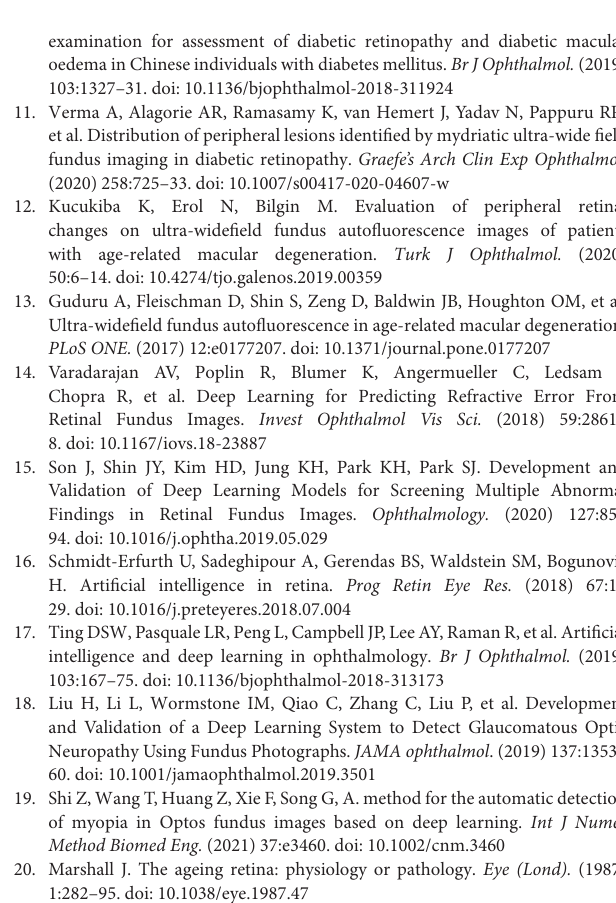
Supplementary Figure 1 | The distributions of refractive error of enrolled eyes. (A) training set; (B) test set; (C) whole data set; (D) External validation set. Supplementary Figure 2 | Distribution of MAE of predicted spherical equivalent. (A) ResNet-50; (B) Inception-v3; (C) Inception-ResNet-v2. Supplementary Figure 3 | Distribution of MAE of predicted spherical equivalent in the external validation set. (A) ResNet-50; (B) Inception-v3; (C)